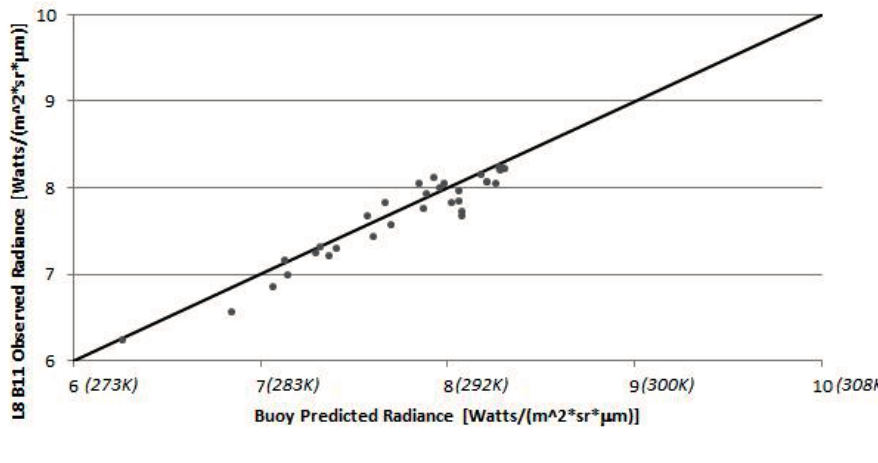
Figure 9. Plot of ToA buoy predicted radiance vs. satellite observed radiance for Landsat 8 band 11 for all data processed automatically (mean error − 0.91 K ± 1.28